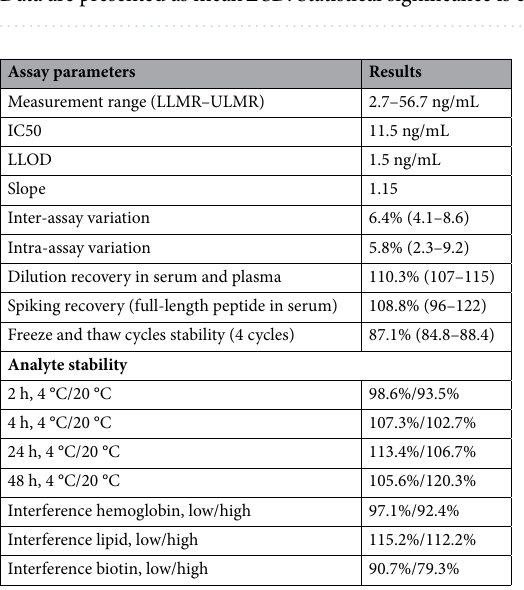
Figure 1. ( a ) Specificity of the monoclonal PAR2 antibody. Monoclonal antibody reactivity towards the selection peptide (QGTSRSSKGR), the elongated peptide (QGTSRSSKGRS), the truncated peptide (QGTSRSSKG) and the full-length PAR2 protein was tested. Two-fold dilutions of the peptides and the PAR2 protein were added starting from 250 ng/ml. The data suggest that the monoclonal antibody is specific only for the selection peptide, which is the target sequence. Data are shown as B/B0, where B represents the RLU at given concentrations and B0 the RLU at 0 ng/ml peptide and are presented as mean ± SD. RLU: relative luminescence units. ( b ) In vitro cleavage of recombinant full-length PAR2 protein with matriptase. Human full length PAR2 protein was incubated with matriptase for 2 and 24 h and PRO-PAR2 levels were quantified with the PAR2 immunoassay. Group comparisons were done using one-way ANOVA with Dunnett’s multiple comparisons. Data are presented as mean ± SD. Statistical significance is considered as * P < 0.05 and **** P < 0.0001.